Question: Which visualization type does this figure use?
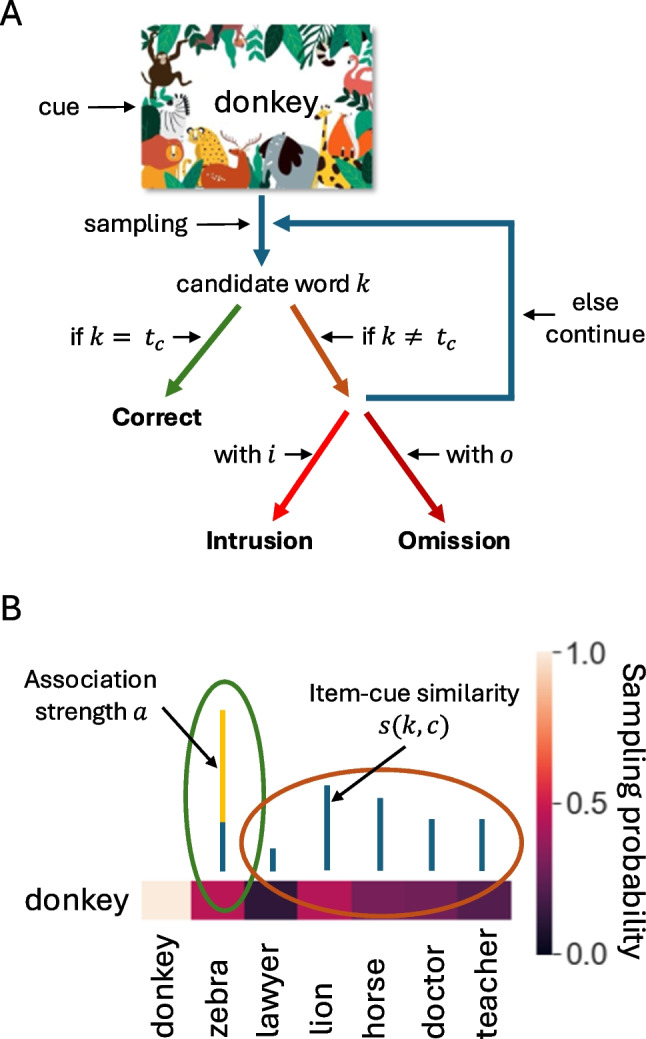
Answer: bar